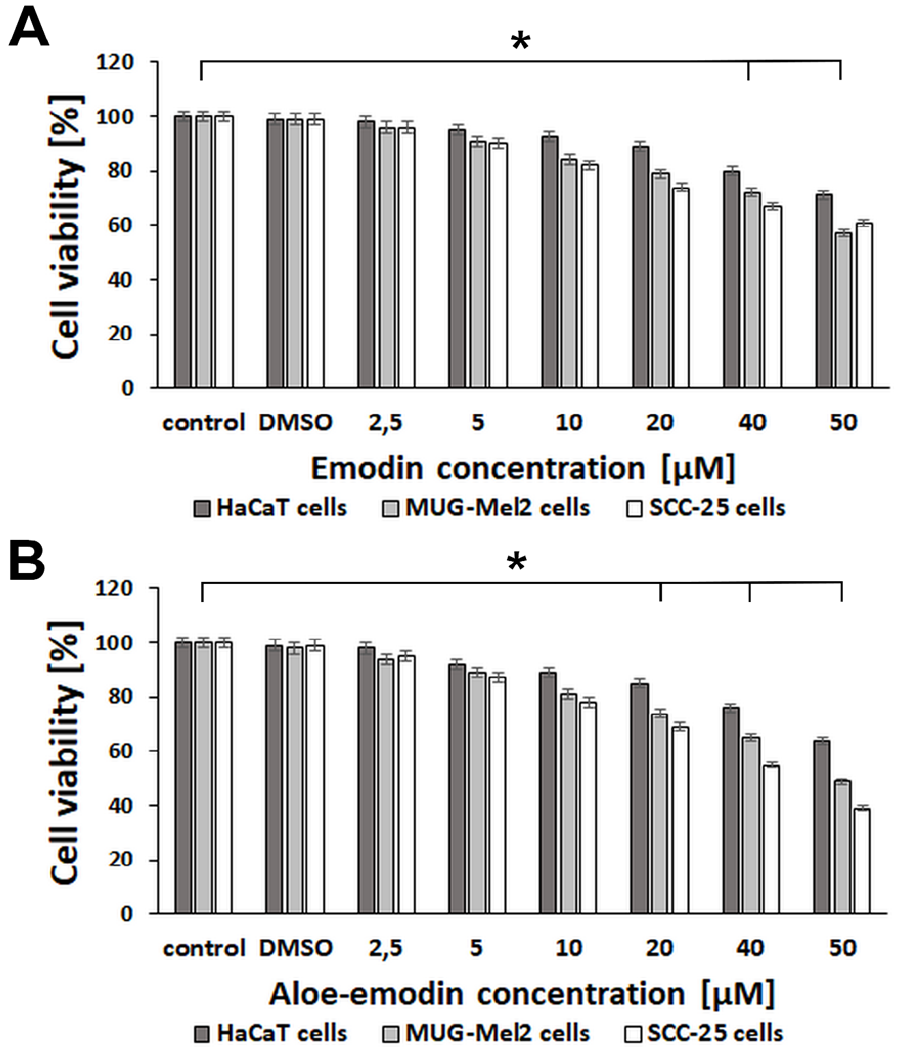
Figure 2. Comparison of HaCaT, MUG-Mel2, and SCC-25 cells viability after 24h incubation with ( A ) emodin or ( B ) aloe-emodin at concentrations of 2.5 –50 μM. Results represent the mean from three different experiments from four wells. * p < 0.05.